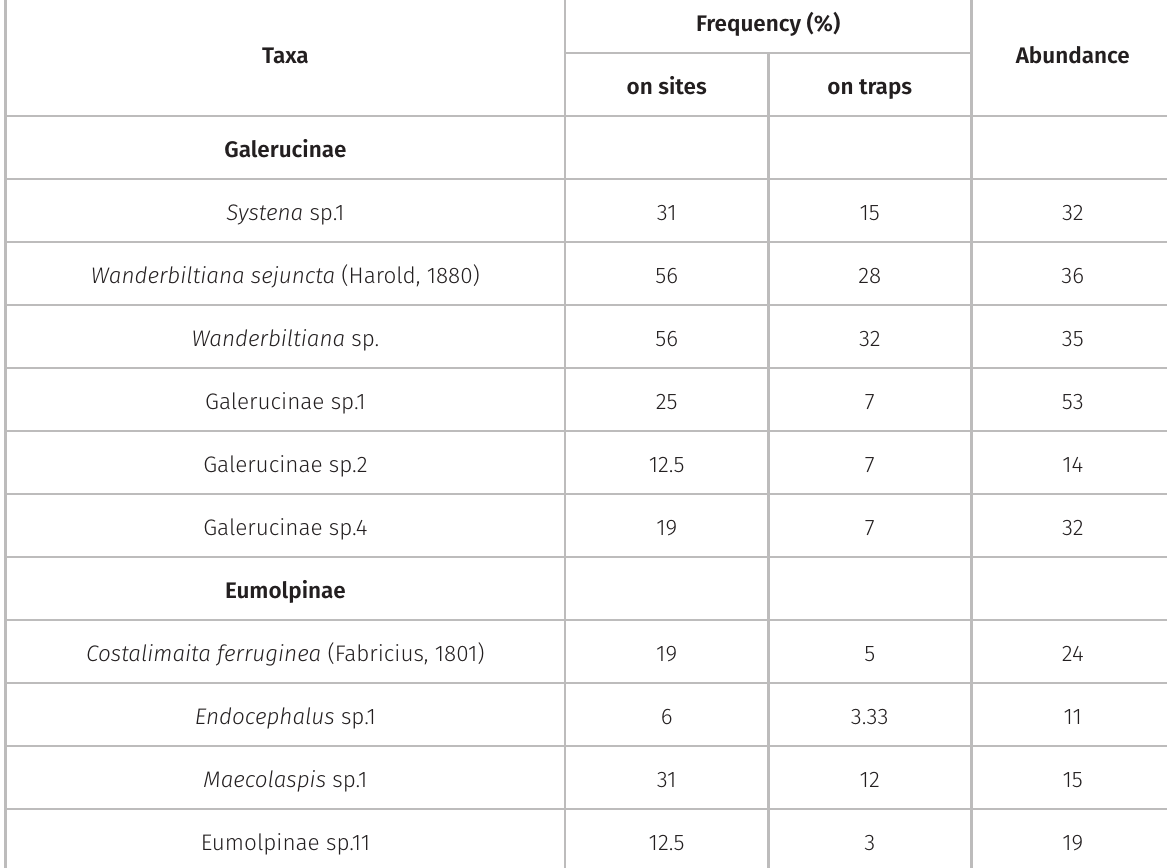
Table II. Frequency and abundance (number of leaf beetles) of most frequent (> 5 fragments) and abundant (≥ 10 leaf-beetles) Chrysomelidae (morpho)species* sampled with Malaise traps in 16 remnants of semi-deciduous forest (sites) in Dourados, Mato Grosso do Sul, Brazil. Frequency (%) Taxa